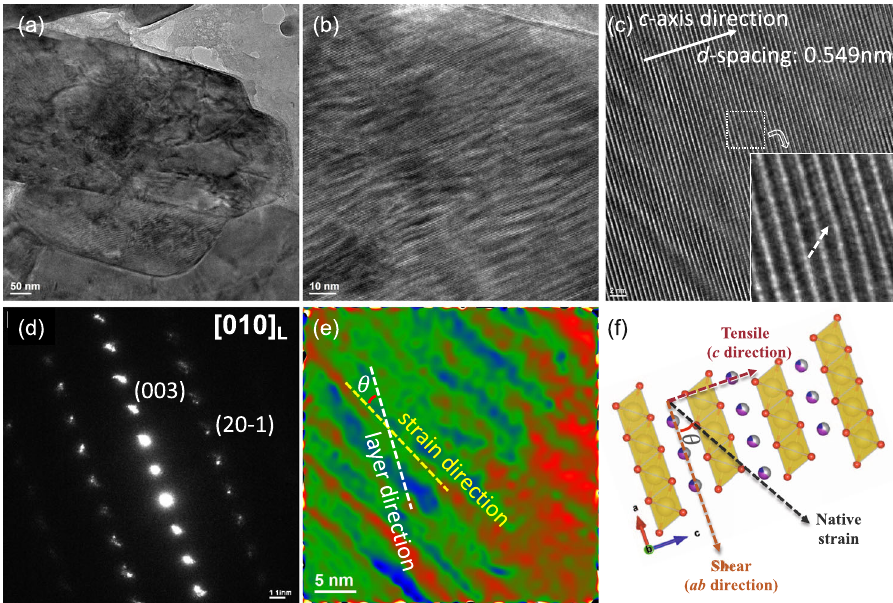
Fig. 4 TEM characterization of pristine O3 NaNi 0.4 Mn 0.4 Co 0.2 O 2 . a Low and b high magni fi cation, c high-resolution bright- fi eld TEM image, d SAED pattern, e GPA analysis and f atomic structural model of the strained O3 NaNi 0.4 Mn 0.4 Co 0.2 O 2 . Inset in c is the zoomed-in view of the region marked by a white square. The color in c represents the intensity, with red for highest and blue for lowest. θ is the angle between layered direction and strain direction. The yellow, red, blue, gray, and purple spheres in f represent Na, O, Ni, Co, and Mn atoms,